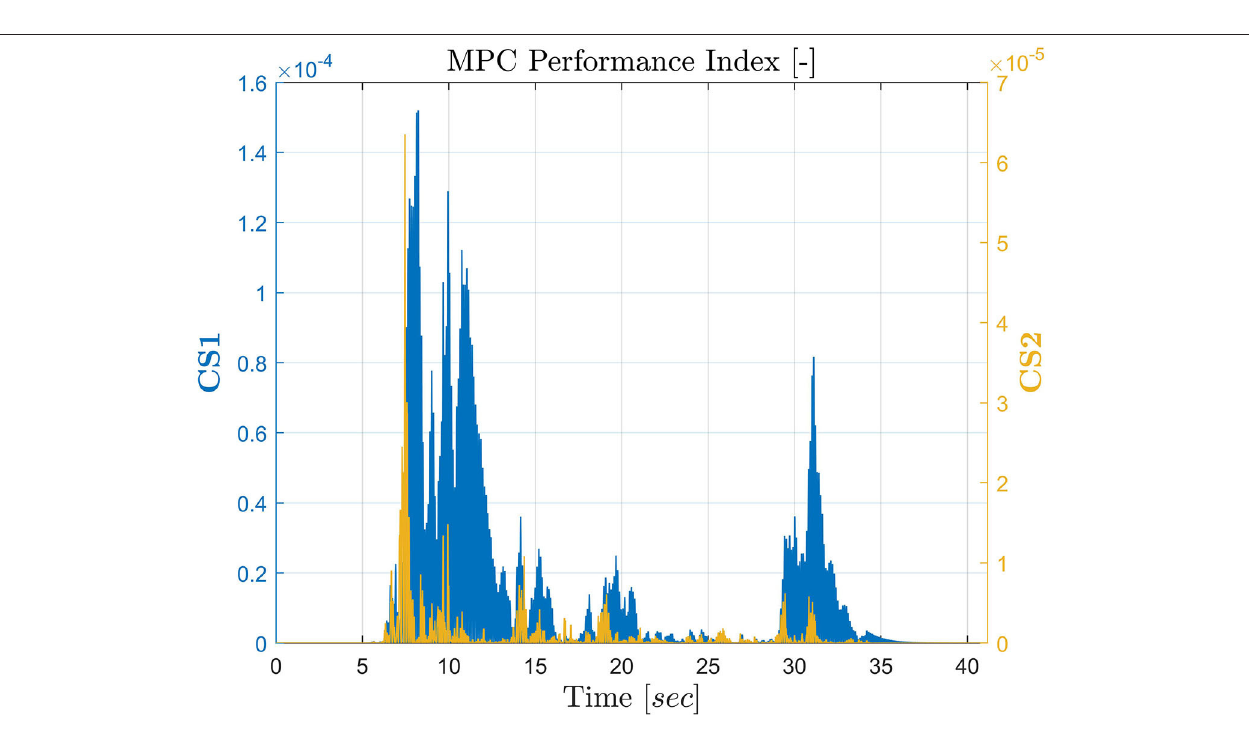
FIGURE 9 | MPC optimization performance index for CS1 and